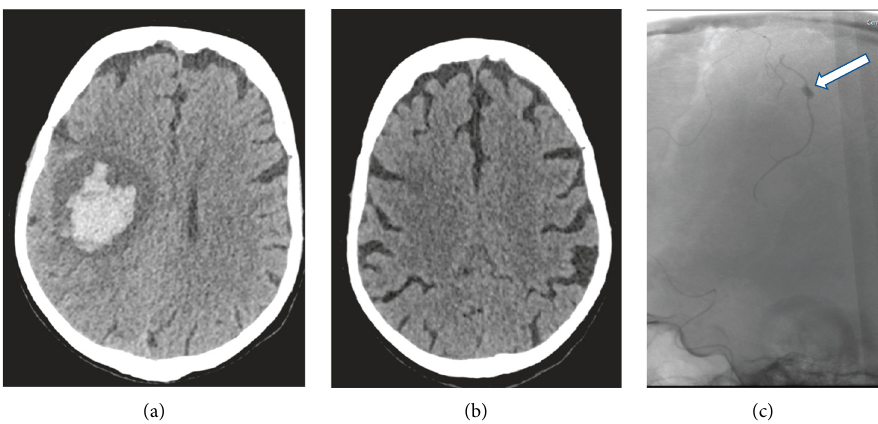
Figure 2: Hemorrhage from ruptured aneurysm right fronto-parietal hematoma (a); previously normal CT brain (b); angiography showing the aneurysm of a branch of the right middle cerebral artery (white arrow)